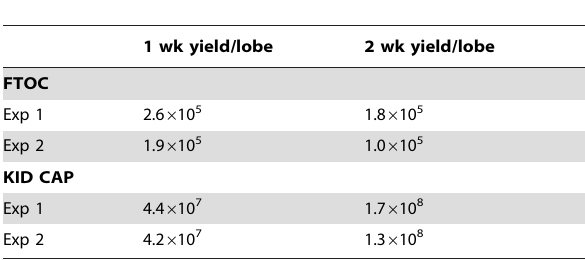
Table 1. Cell yields following FTOC or kidney capsule transplantation of 14 day fetal